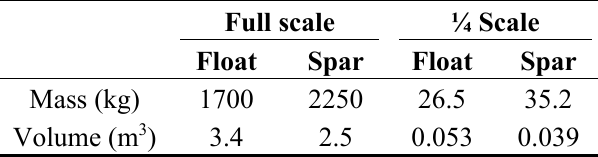
Figure 1. Autonomous Wave Energy Converter (AWEC): ( a ) full scale and ( b ) ¼ scale. All dimensions in meters. The float is toroidal shaped, half submerged in still water, around a central spar body. Table 1. AWEC mass